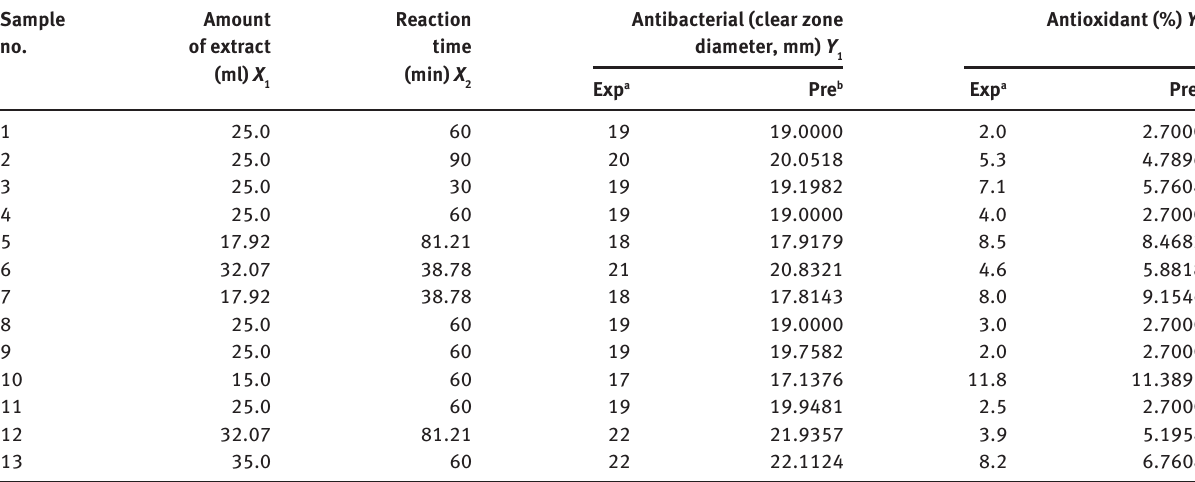
Table 1: Experimental runs according to the central composite design and response variables for ZnO NPs synthesis. Sample no.